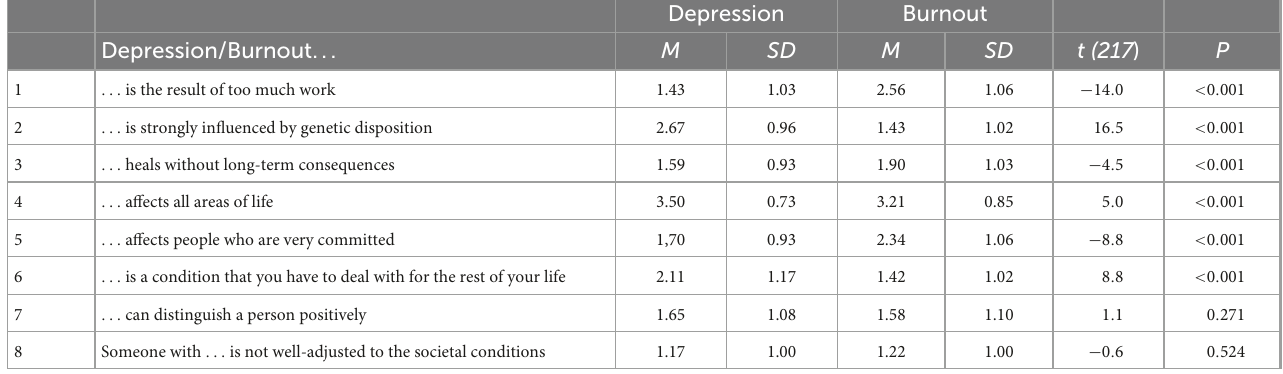
TABLE 2 Concepts of depression and burnout.